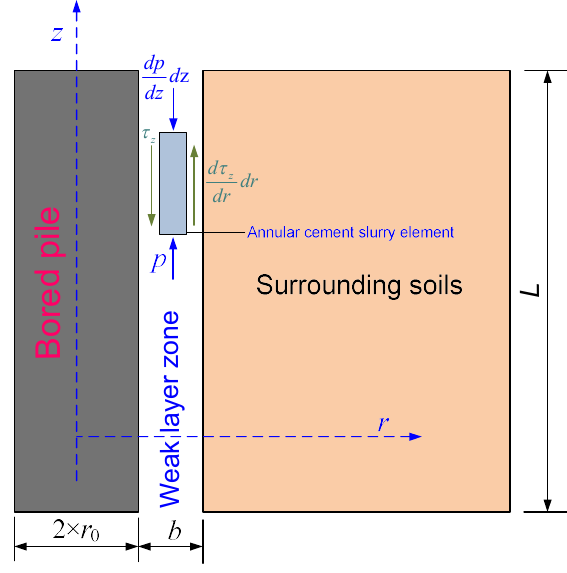
Figure 2. Strained condition of grout in an annular space.